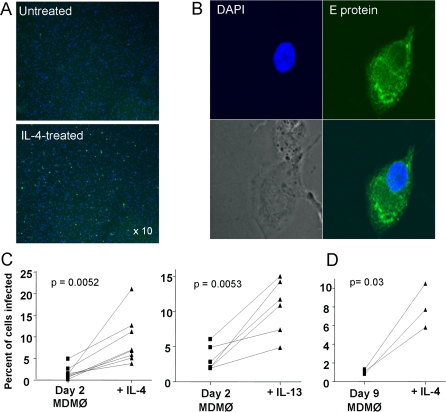
IL-4 and IL-13 Enhance Monocyte and MØ Susceptibility to DV InfectionMonocytes isolated from human peripheral blood were either treated with IL-4 or IL-13 or were left untreated for 2 d (day 2 MDMØ) prior to infection with dengue virus. Two days following infection, permeabilized cells were stained with antibody to dengue E protein (green) and nuclei stained with DAPI (blue).(A) Low power image. (B) Single DV-infected cell confocal image showing DV protein distributed throughout the cytoplasm. Image represents a single x-y section through the middle of a cell. Fluorescence images are shown next to the corresponding transmission image. (C) The percentage of cells infected was counted by microscopy. Each line represents a single donor. (D) Monocytes were matured into MDMØ by 7 d incubation prior to treatment with IL-4 for 2 d (day 9 MDMØ). Cells were infected with DV and stained, and percent infected cells calculated.